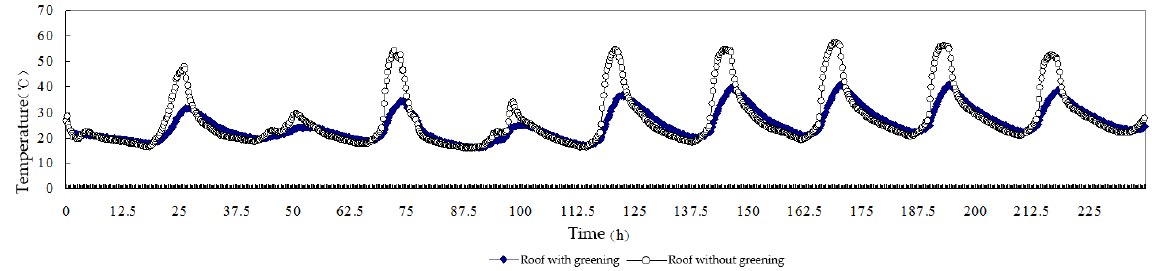
Figure 6. Temperature comparison with and without roof greening.